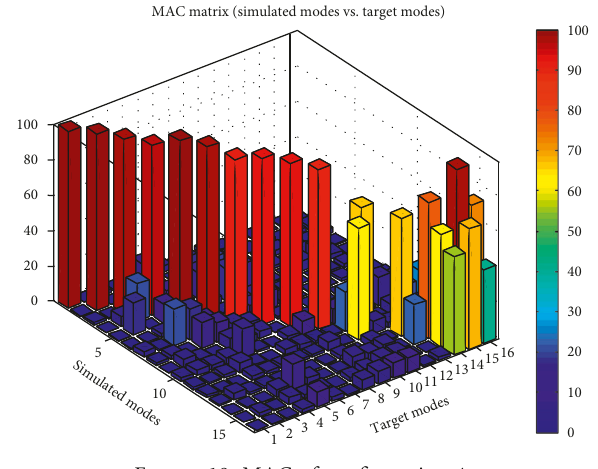
Figure 18: MAC of configuration 4.